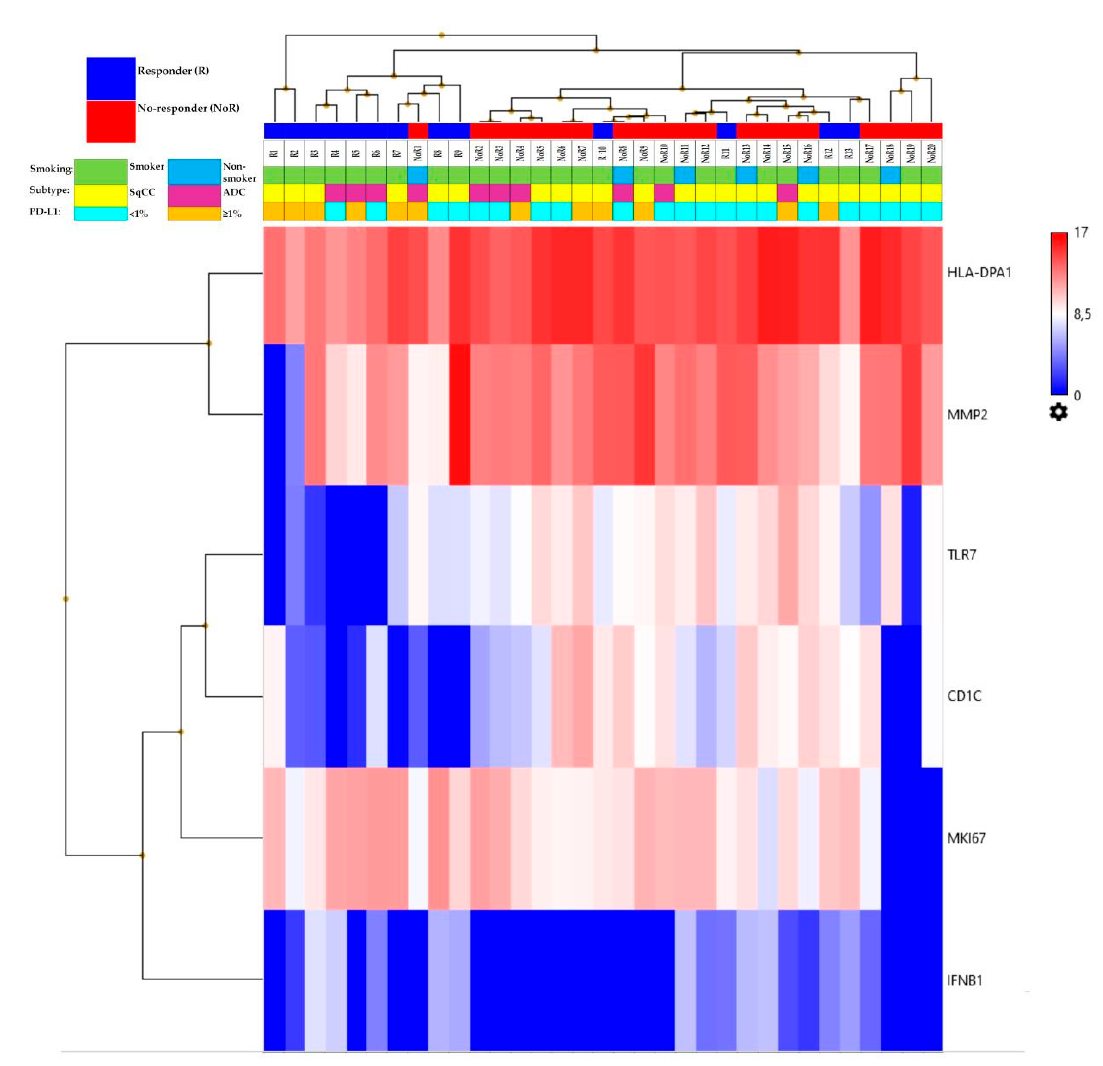
Figure 1. Heatmap of the genes differentially expressed between ICI-Responders and ICI-Non-Responders.